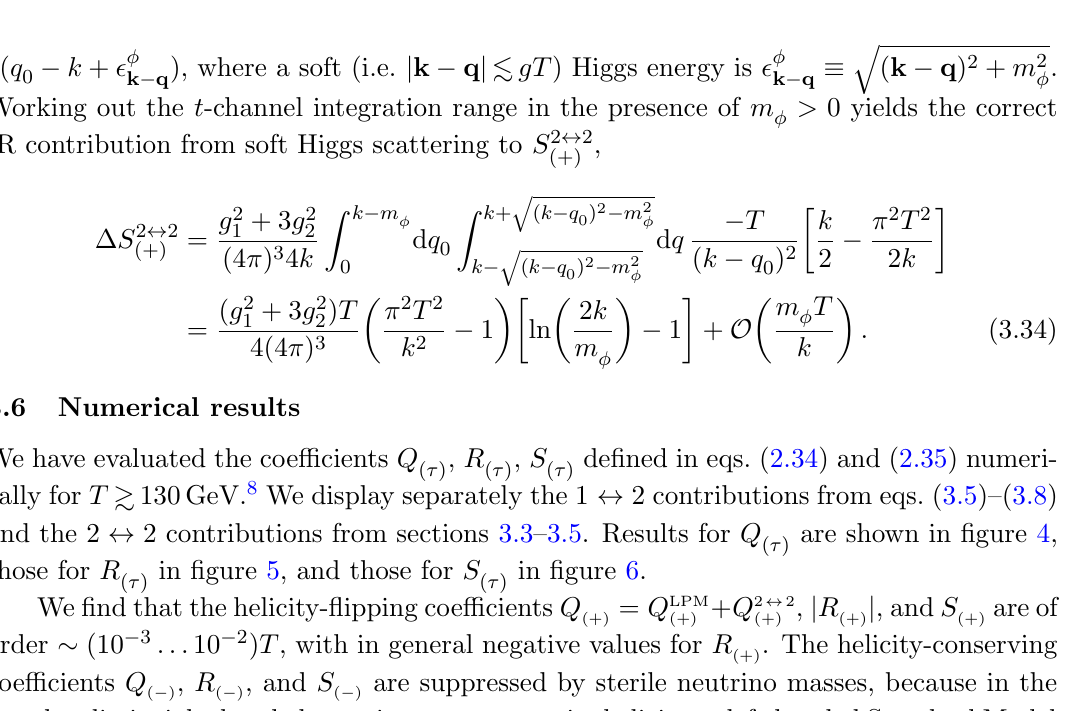
Figure 4 . Left: the coe(cid:14)cient Q from eq. (2.34), for (cid:12)xed k = 3 T and M ( (cid:28) ) IJ 2 f 0 : 5 ; 1 ; 2 ; 3 ; 4 g ; the dependence on M is moderate, and the dependence on M J celled by the normalization chosen. There is a mild divergence at the location of the electroweak crossover, indicating that the perturbative computation becomes unreliable there. Right: the same for (cid:12)xed M = 2 GeV and k=T 2 f 1 ; 2 ; 3 ; 6 ; 9 g . One curve has been labelled, with the dependence J on k=T being